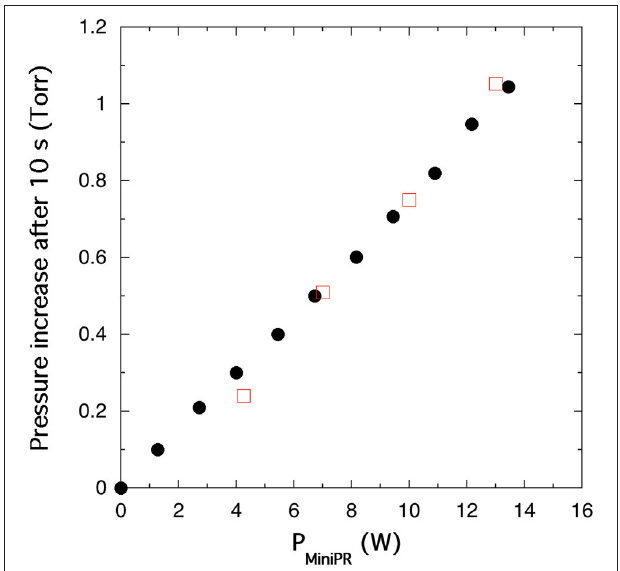
FIGURE 7 | Ignition (lowest values), extinction (highest values) Converter frequencies measured vs. argon gas flow rate under turbo-molecular pumping (solid black dots) and cryogenic pumping (solid red squares) using the WOMBAT vacuum test configuration of Figure 2 and pulsed operation at 40 kcycles. “Nominal” frequency yielding immediate plasma striking at a constant P MiniPR value of 1.54 W for the turbo-molecular pumping case (black crosses) and cryogenic pumping case (red crosses); for the 30 sccm case the measured effective pumping speed is 1,250 and 6,000 l.s − 1 for the turbo-molecular and cryogenic pumping cases, respectively; for each flow rate the sweep is performed from low to high